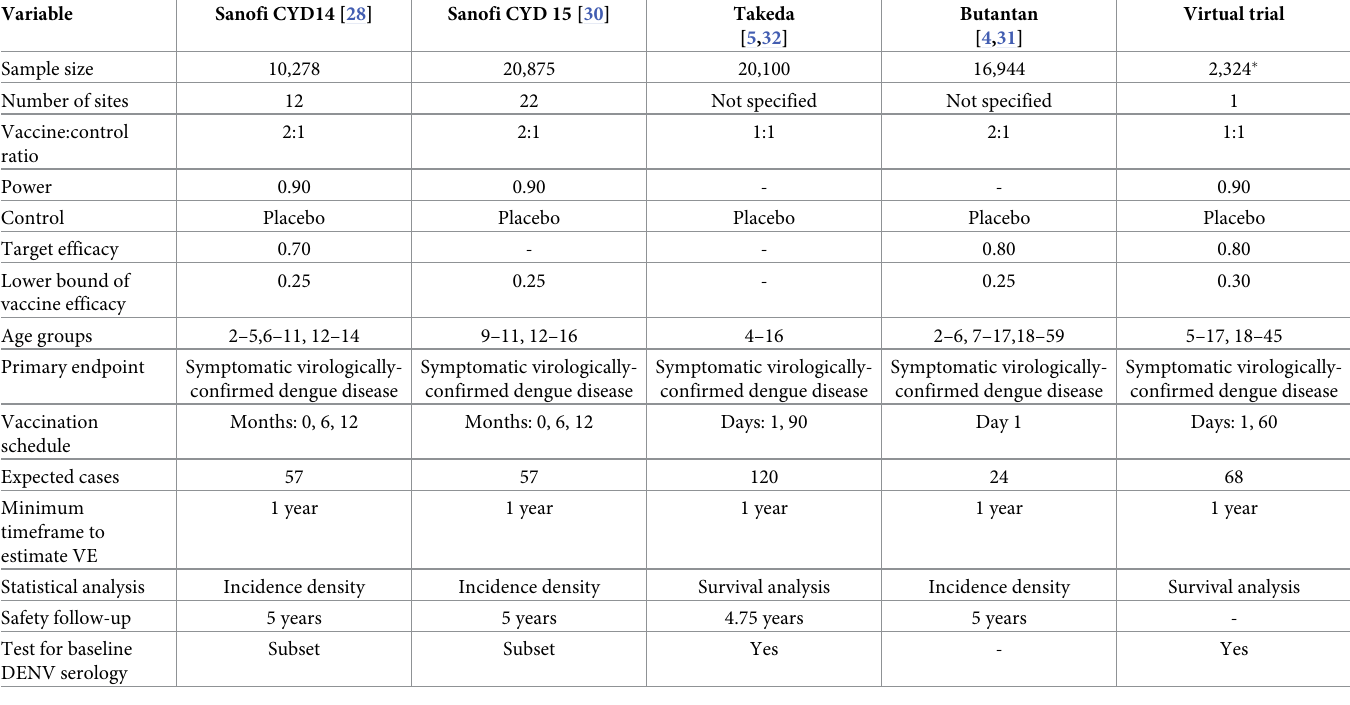
Table 1. Characteristics of four vaccine trial designs for dengue vaccines, in addition to our virtual